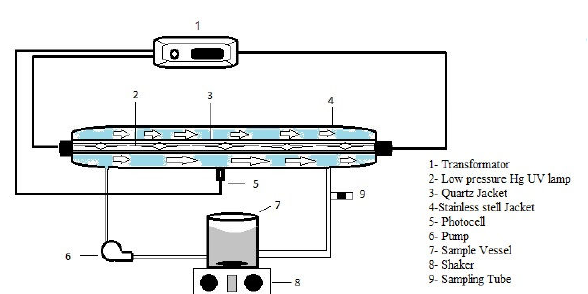
Fig. 1. Schematic view of experimental reactor